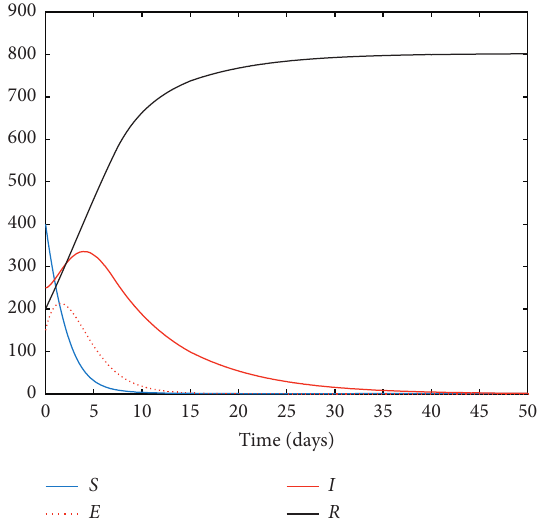
Figure 7: Evolution of the populations with the constrained control actions and n � 15 days.